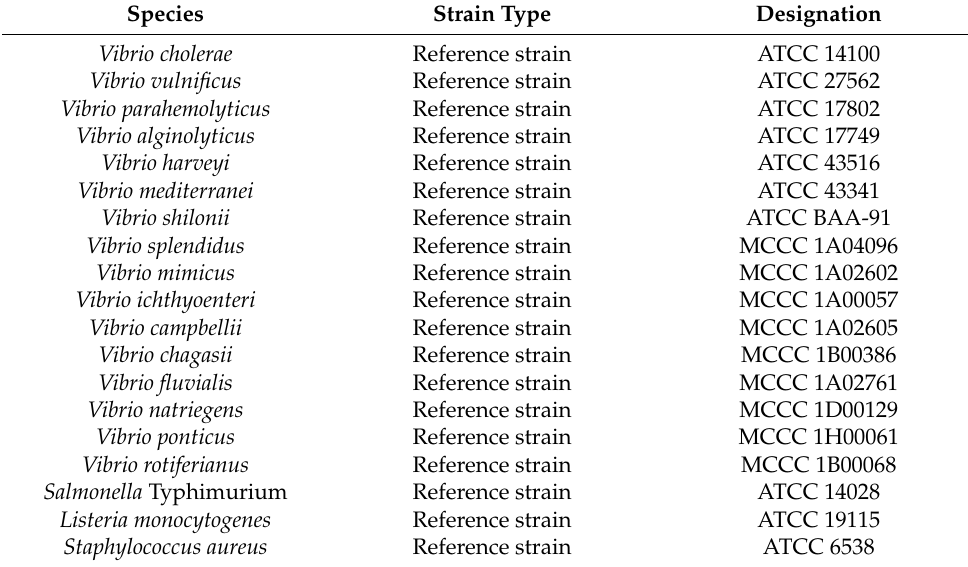
Table 1. Bacteria strains used in this study.